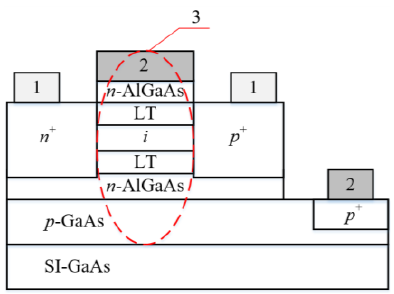
Fig. 1. The cross-section of the photodetector with controlled relocation of carrier density peaks: 1 – supply contacts; 2 – control contacts; 3 – control heterostructure.